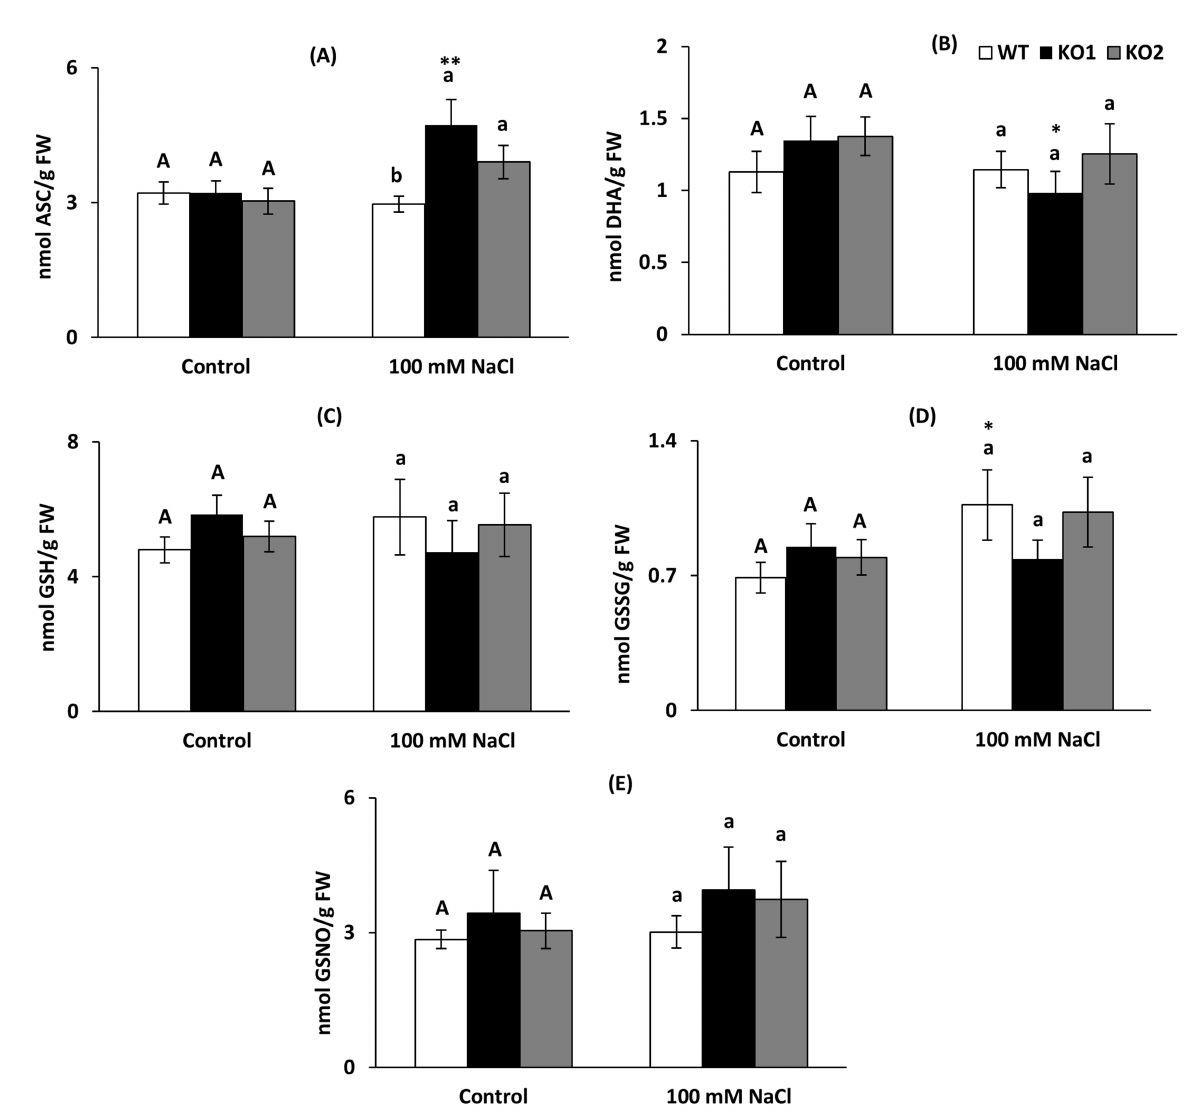
Figure 6. Ascorbate, glutathione and nitrosoglutathione content in leaves of A. thaliana wild type (WT) and two KO Attrxo1 mutant lines grown in the absence (Control) and presence of 100 mM of NaCl. ( A ) Reduced ascorbate (ASC), ( B ) dehydroascorbate (DHA), ( C ) reduced glutathione (GSH), ( D ) oxidized glutathione (GSSG) and ( E ) nitrosoglutathione (GSNO) content per fresh weight (FW). Data are the mean ± SE of at least three independent experiments. Different letters indicate significant differences ( p < 0.05) among genotypes in each condition according to the Tukey’s test, and the asterisks indicate significant differences of each genotype in salinity compared to the control condition using the t -Student’s test (*, ** at p < 0.05 and p < 0.01,